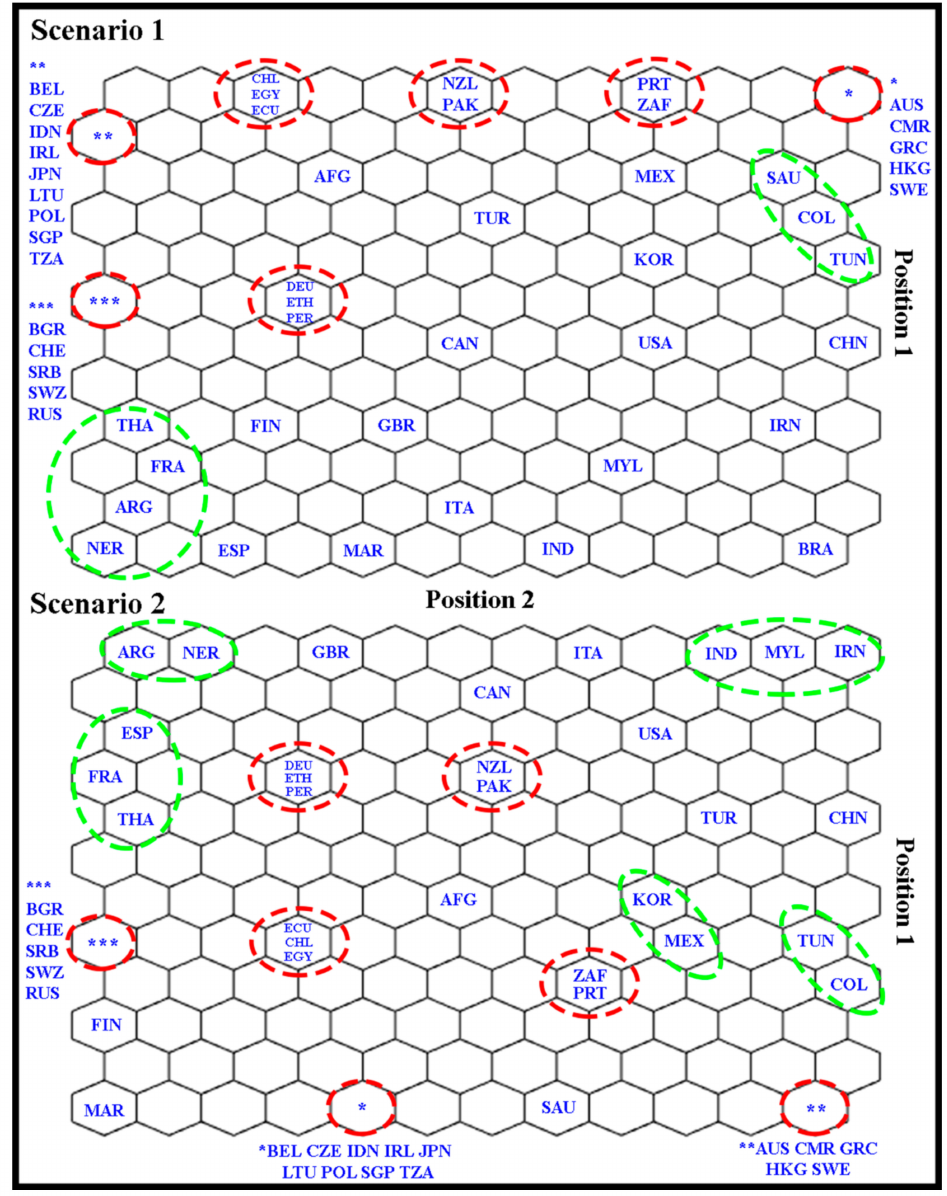
Figure 3. Countries distribution according to the winning neuron for both scenarios. After analyzing the topological map that represents the countries distributed in each winning neuron (Figure 3), the respective weight maps for application areas of the MDs were generated, shown in Figure 4. Further discussion for each area will be given in the fol- lowing sections. The weight maps represent the topological map overlay for the continent’s segmentation, and the color scale indicates the observed values for the input